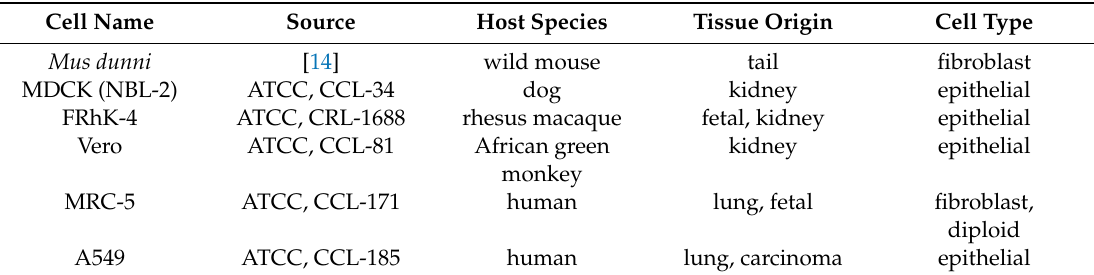
Table 1. Cell lines used in infectivity